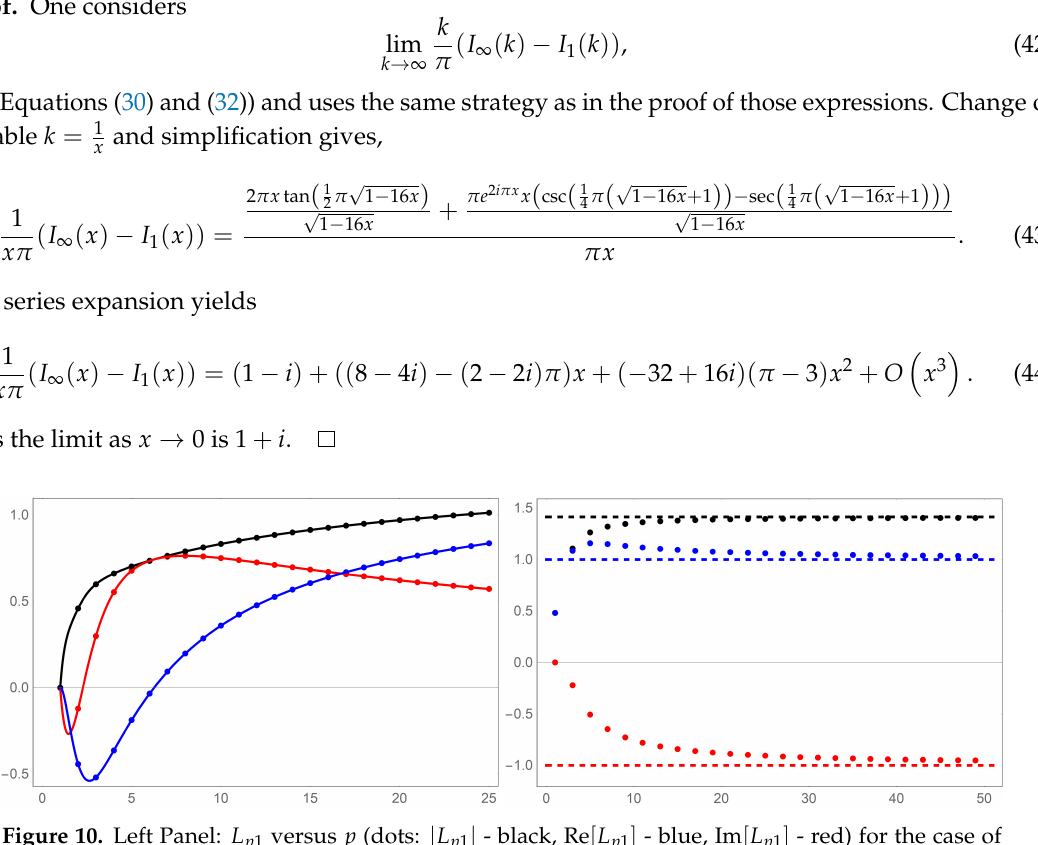
L ∞ 1 versus k ( | k L ∞ 1 | - black, π π L ∞ 1 = 1 − i π